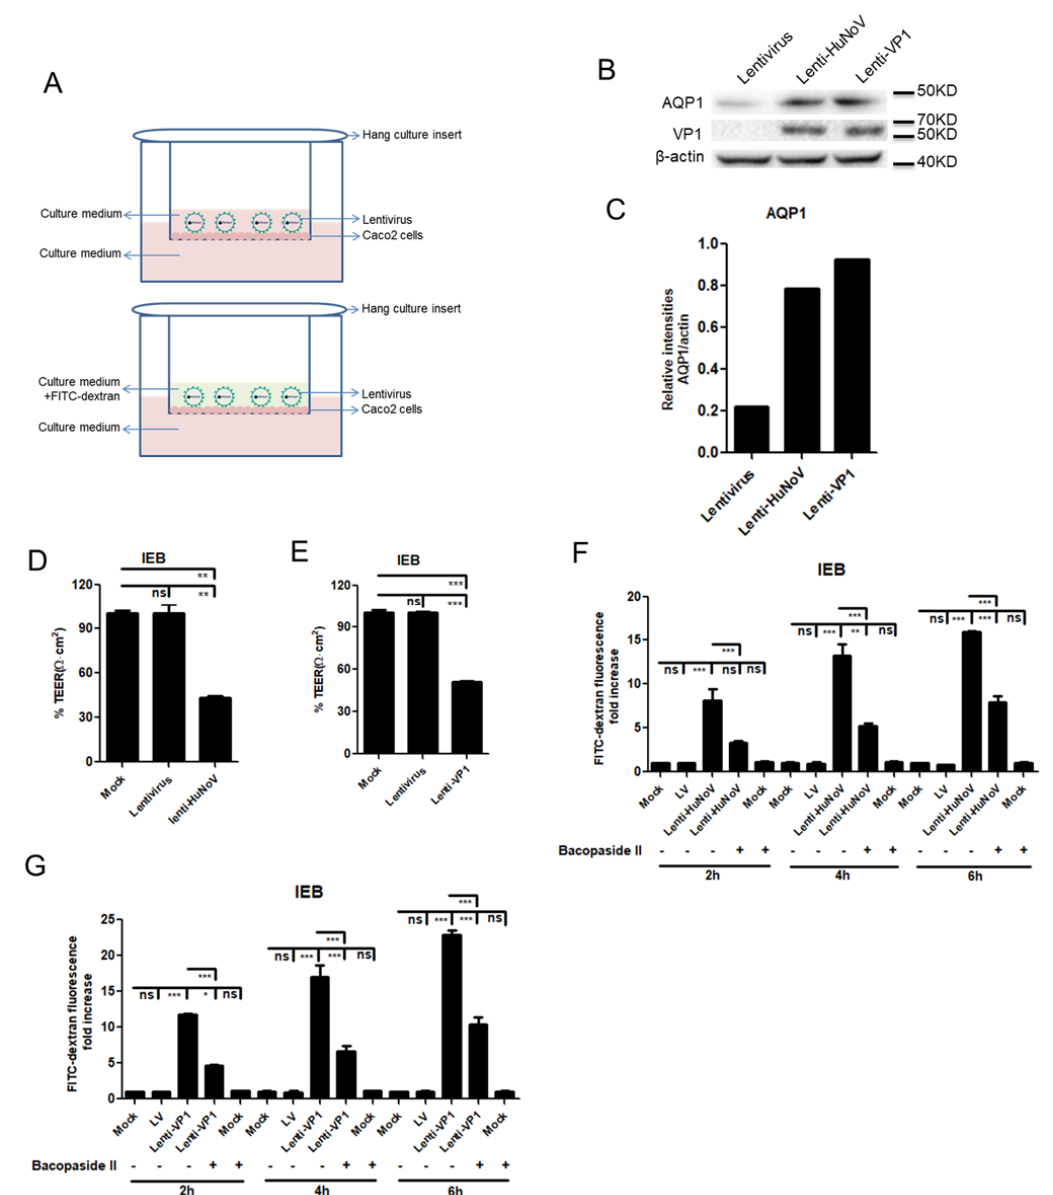
Figure 6. HuNoV increases the permeability of intestinal epithelial barrier. ( A ). The model of IEB. ( B , C ). Lenti-HuNoV or Lenti-VP1 transduction induced the production of AQP1. ( D , E ). HuNoV and VP1 significantly decreased the value of TEER. ( F , G ). HuNoV and VP1 promoted penetration of small molecular FITC–dextran. IEBs were transduced with empty lentivirus, lenti-HuNoV or lenti-VP1 at an MOI of 1 for 3 d. Cells were lysed, and the expression of AQP1 was detected by WB ( B ). The relative intensities of AQP1 blots were quantified ( C ). The value of TEER was meas- ured by voltmeter ( D , E ). The IEB were pretreated with or without Bacopaside II for 1 h before FITC-conjugated dextran (1 mg/mL) was added to the upper chamber of Transwells. At the indi- cated time, 100 μL of sample in the lower chamber was collected and quantified using VARI- OSKAN FLASH (Thermo Scientific) ( F , G ). For graphs, data shown are the mean ± S.D. of three independent experiments with each condition performed in triplicate. For images, one representa-